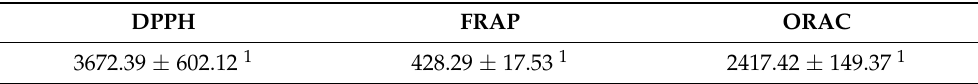
Table 2. Antioxidant capacity of hydrophilic extracts from spent coffee grounds.